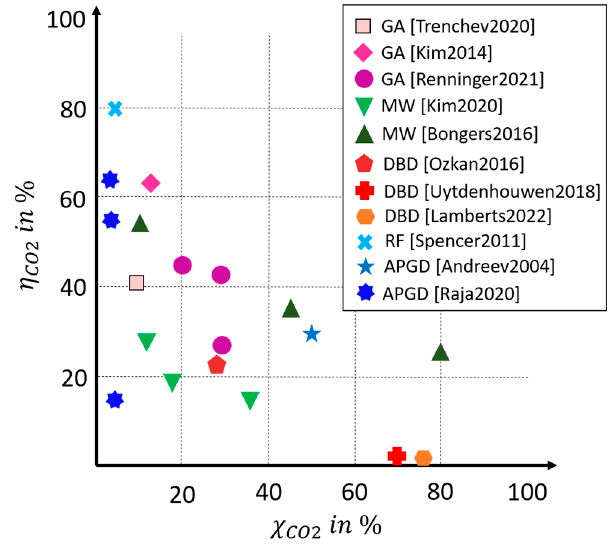
Figure 2. Experimental conversion rates χ CO and energy efficiencies η CO 2 of plasma technologies for CO 2 conversion [Renninger2021] [27]: gliding arc discharge (GA) performed by Trenchev et al. [Trenchev2020] [28], Kim et al. [Kim2014] [29] and Renninger et al. [Renninger2021] [27]. Microwave plasma (MW) was performed by Kim et al. [Kim2020] [30] and Bongers et al. [Bongers2016] [31]. Dielectric barrier discharge (DBD) was performed by Ozkan et al. [Ozkan 2016] [32], Uytdenhouwen et al. [Uytdenhouwen2018] [33], and Lamberts et al. [Lamberts2022] [34]. Radio frequency discharge (RF) was performed by Spencer et al. [Spencer2011] [35]. Atmospheric glow discharge plasma (APGD) was performed by Andreev et al. [Andreev2004] [36] and Raja et al. [Raja2020] [37].